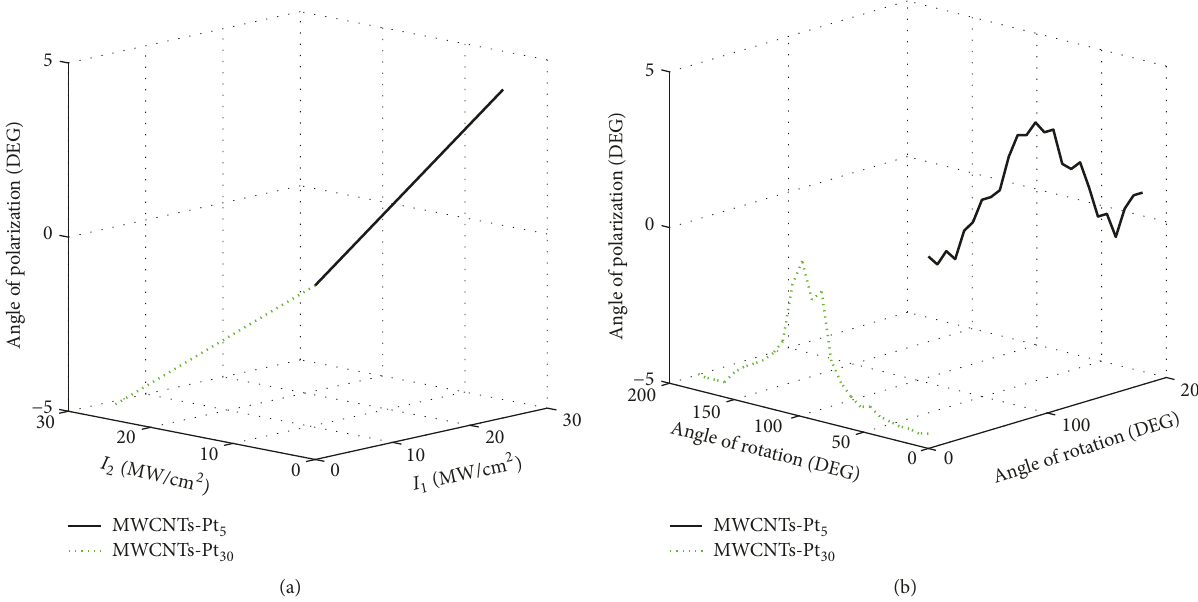
Figure 5: (a) Angle of polarization versus irradiance of the control beams. (b) Angle of polarization versus angle of rotation of the